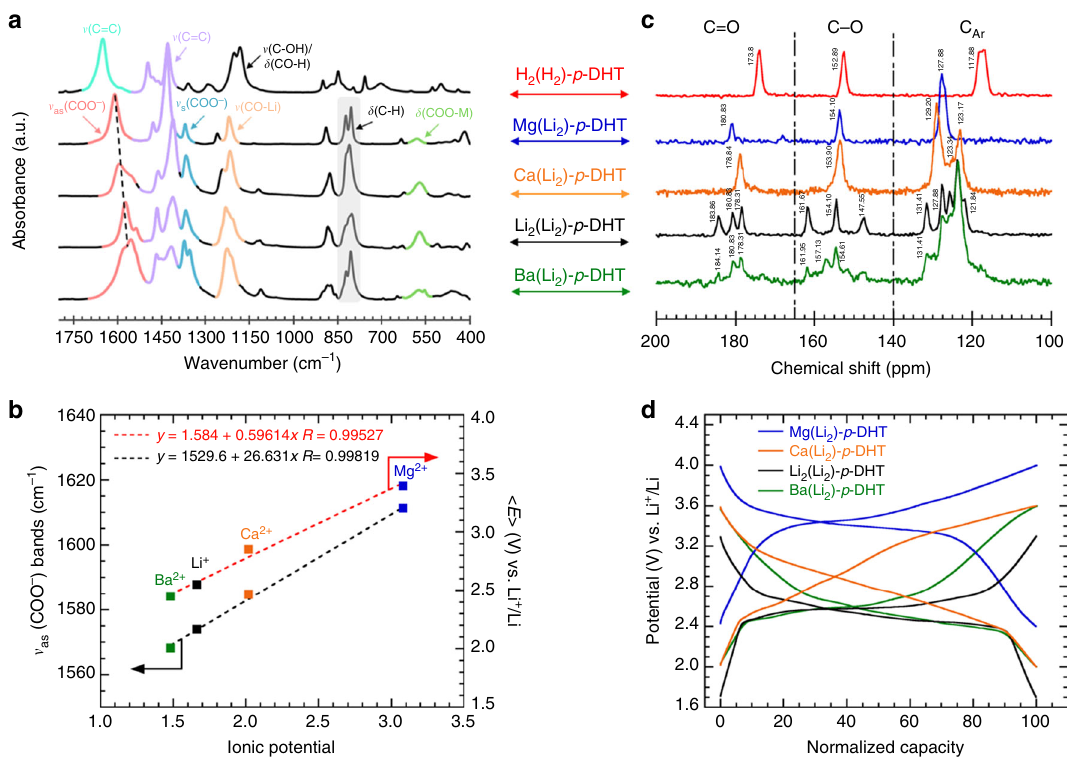
ð Li Þ - p - DHT electrode materials (M n + = Li + , Mg 2 + , Ca 2 + and Ba 2 + . a Overlaid FTIR spectra of Ba(Li Fig. 5 Charge perturbation in M n þ 2 2 = n Li 2 (Li 2 )- p -DHT (black), Ca(Li 2 )- p -DHT (orange) and Mg(Li 2 )- p -DHT (blue), including that of the acid form of the ligand, namely H 4 - p -DHT or H 2 (H 2 )- p - DHT (red), for comparison. b Correlation between both the antisymmetric vibrational modes of the carboxylate functional groups, ν as (COO − ), and the average operating potential < E > (determined from differential capacity data) against the ionic potential of M n + . The dotted line is the linear fi tting. c Overlaid 13 C CP MAS-NMR spectra following the same order as in a . d Overlay of the as-obtained typical galvanostatic curve for each organic salt (2nd cycle) after normalization of the restored capacity (rate: 1 Li + /5 h, active material with 33 wt.% Ketjenblack EC-600JD; electrolyte: LiPF 6 1 M in